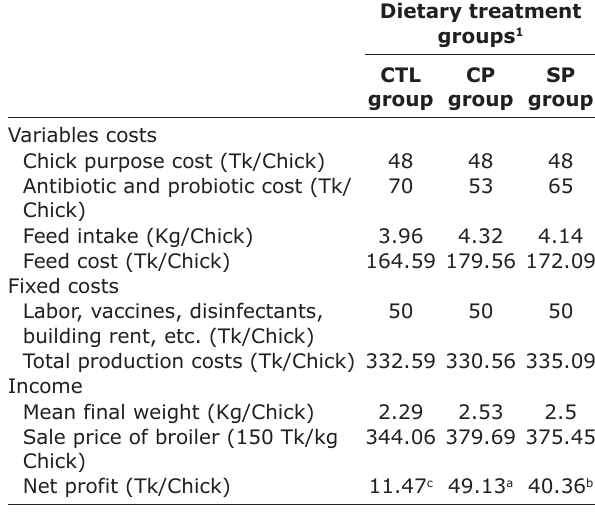
Table-4: Effects of dietary probiotic treatments on biochemical parameter of broiler chickens. Biochemical parameter